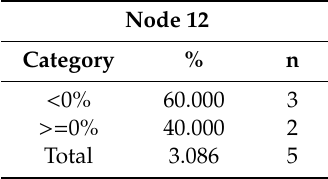
Table 11. The classification results for N04 (San Jose Mercury News) at Node